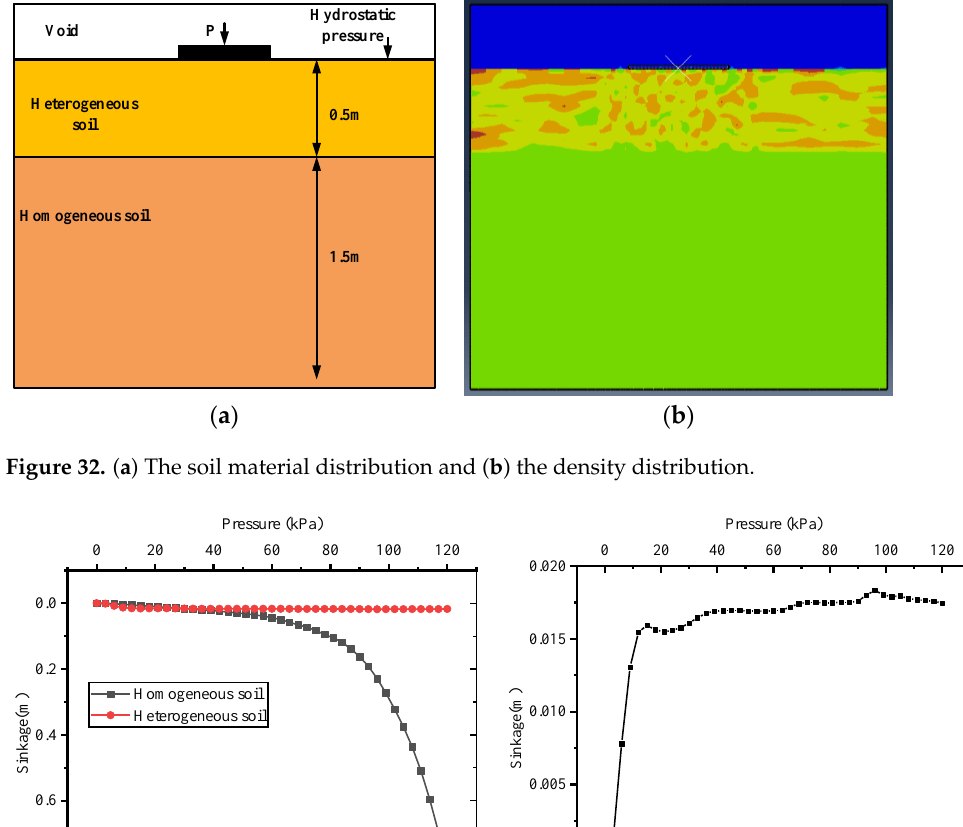
Figure 32. ( a ) The soil material distribution and ( b ) the density distribution.